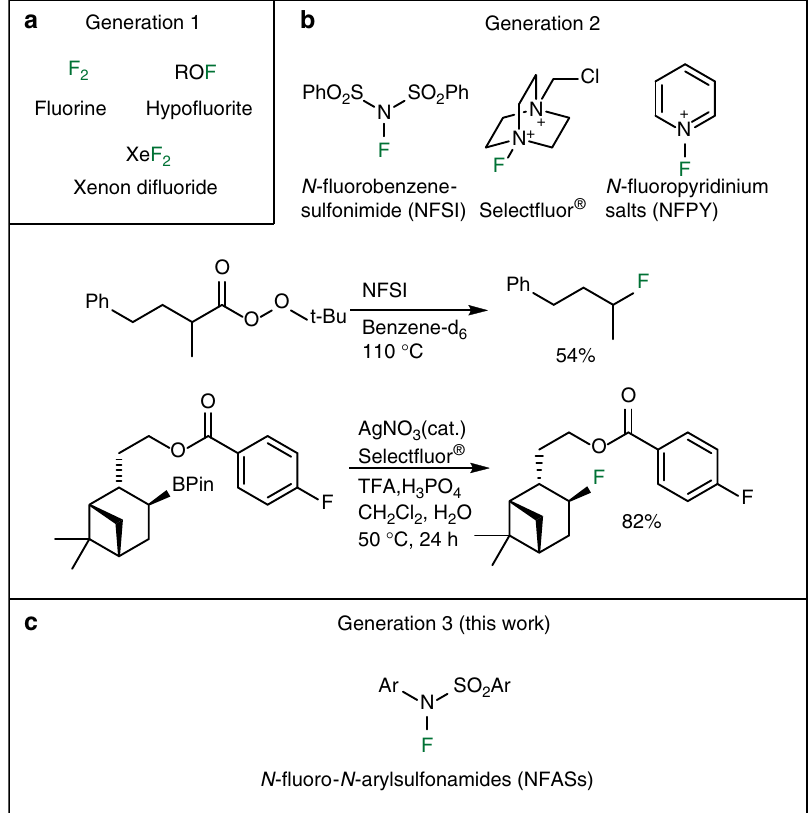
Fig. 1 The three generations of reagents for radical fl uorination. a Fluorination reagents of fi rst generation. b Example of fl uorinative decarboxylation and deboronation reactions using reagents of the second generation. c General structure of the N - fl uoro- N -arylsulfonamides (NFASs) described in this